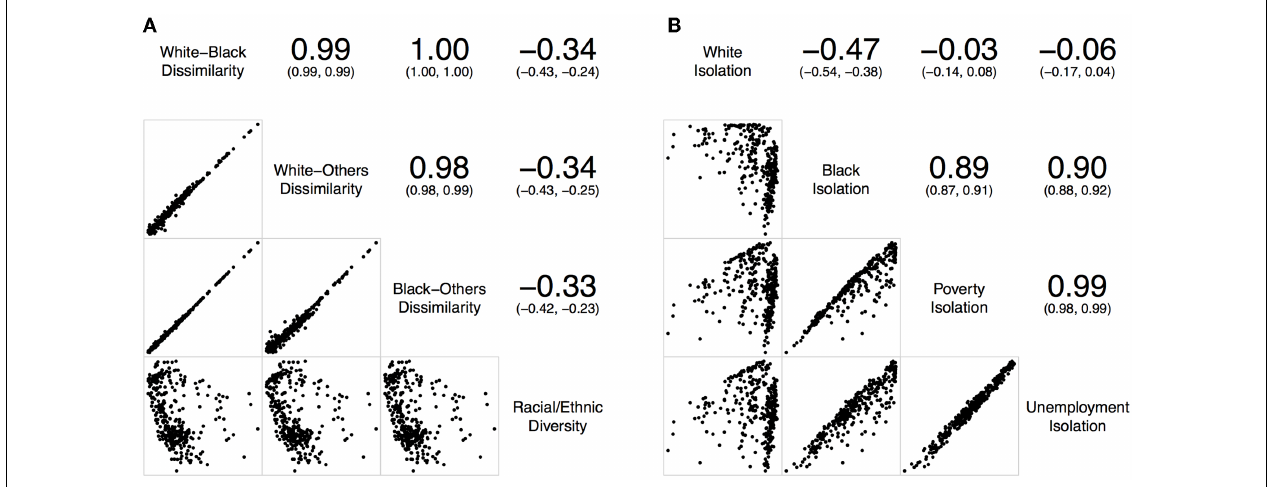
FIGURE 2 | Correlations of local spatial segregation measures in St. Louis, MO, USA (340 census tracts) . (A) With respect to the evenness (i.e., dissimilarity and diversity) dimension, and (B) with respect to the isolation